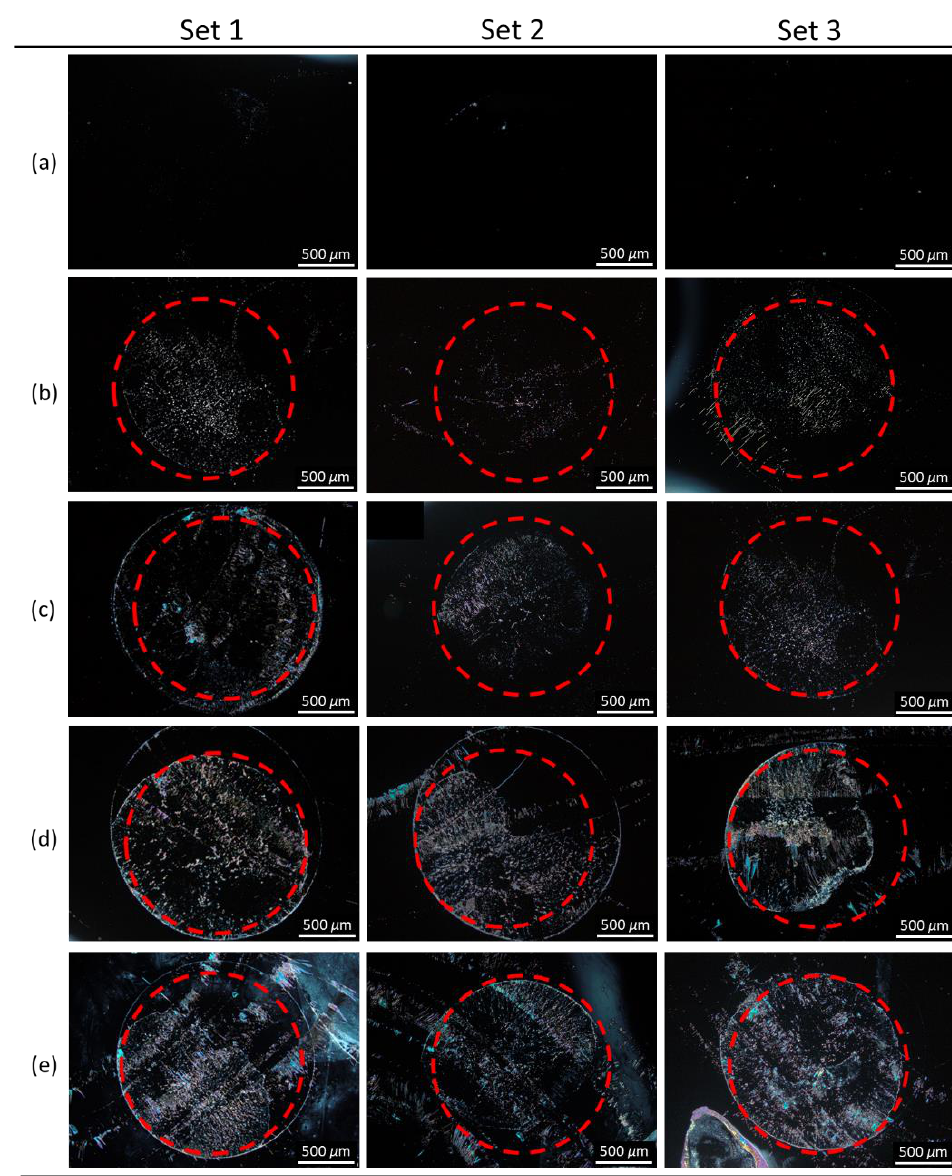
Figure 9. Polarized optical textures of spin-coated HDN films in the presence of the CA125 protein. The nematic LC HDN was spin-coated on DMOAP-coated substrates immobilized with 10 − 8 g/mL anti-CA125 antibody and reacted with CA125 at concentrations of ( a ) 10 − 9 , ( b ) 10 − 8 , ( c ) 10 − 7 , ( d ) 10 − 6 , and ( e ) 10 − 5 g/mL. Each red dashed circle represents the area within which the anti-CA125 antibody was immobilized. Sets 1 – 3 represent results of three independent experiments. Scale bar, 500 μ m.